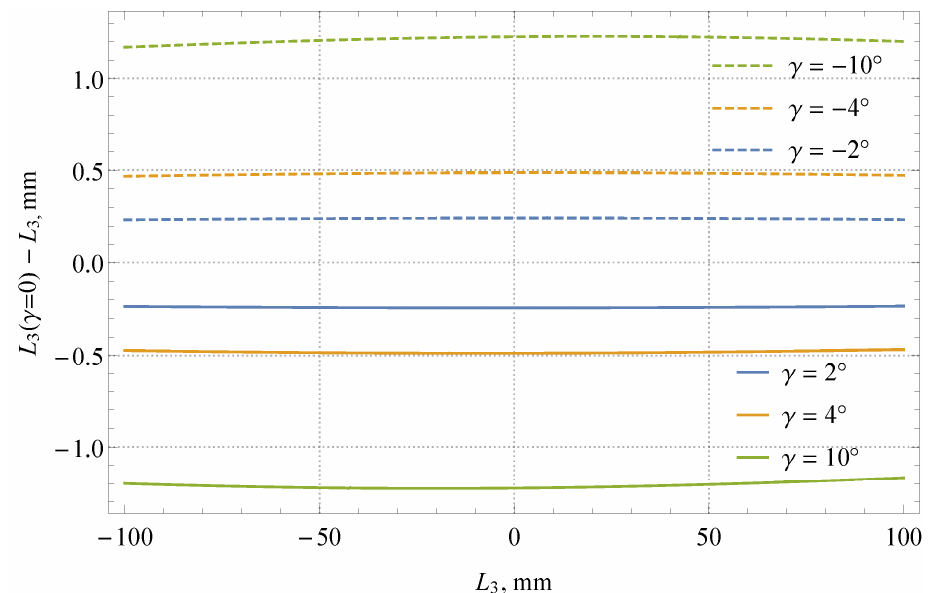
Figure 5. Difference of parallax effects for a camera positioned perpendicular to the measuring scale and for a tilted camera (simulation made for d = 240 mm, d s = 5 mm, d g = 3 mm, and n 2 / n 1 = 1.52).